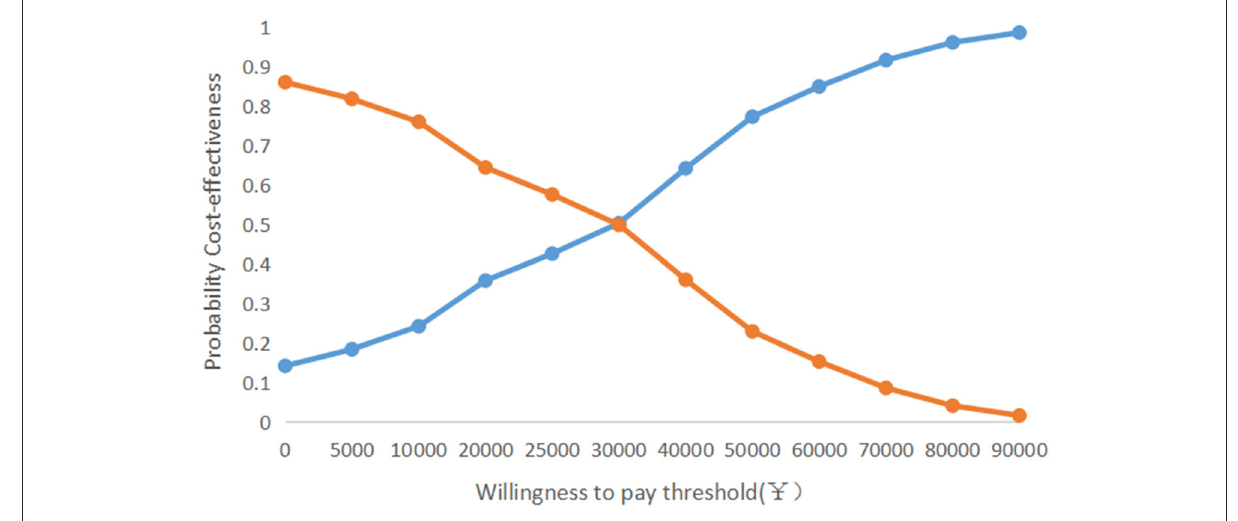
FIGURE3 Cost-effectiveness acceptability